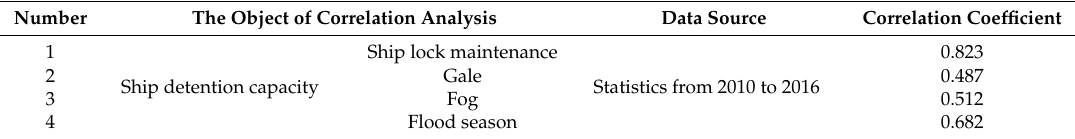
Table 13. Analysis of correlations between ship backlog and key